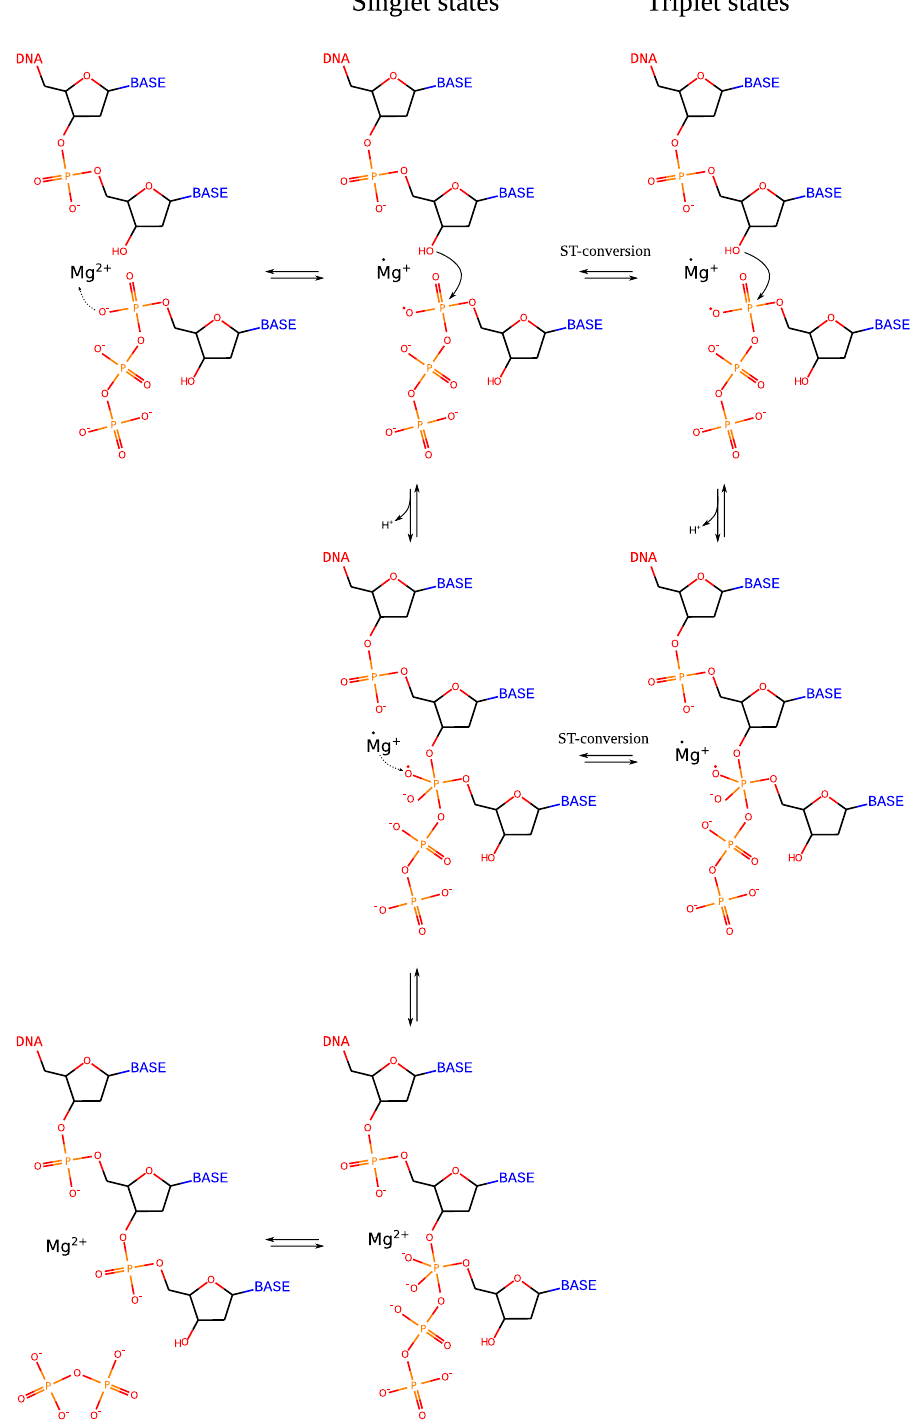
Figure 2. Principal scheme of the ion-radical mechanism supposed to describe the origin of the magnetic isotope effect in the reaction of the DNA synthesis by DNApol β enzyme. The electron transfer is marked by dotted arrows, while the nucleophilic attack – by the plain ones. The scheme was reproduced from Buchachenko et al., 2012 8 with